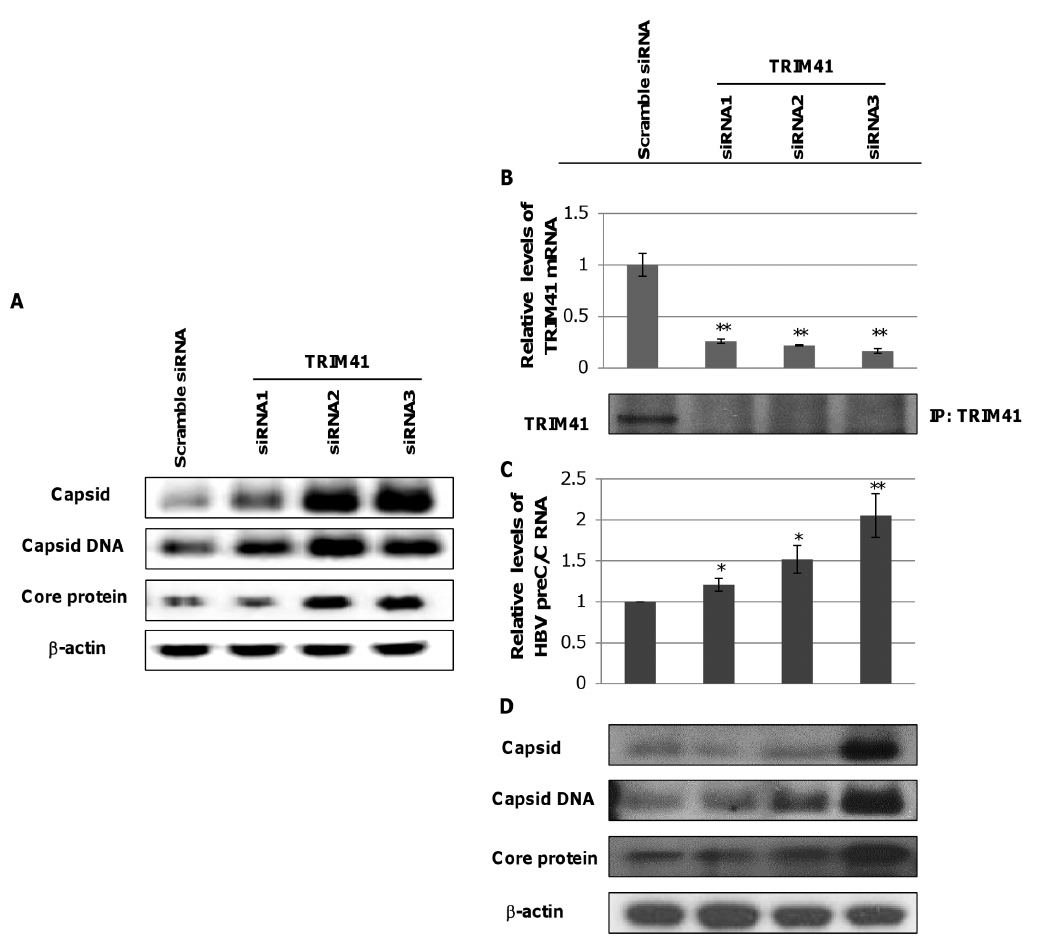
Figure 7. Endogenous TRIM41 inhibits HBV transcription in HepG2 cells. (A) HepG2 cells in 12 well plates were transfected with 20 nM of scramble siRNA or one of three siRNA specifically targeting TRIM41. Six hours later, the cells were co-transfected with 0.4 m g of pHBV1.3 and 0.4 m g of a plasmid expressing TRIM41. The cells were re-transfected with 20 nM of siRNA 24 hours later and harvested at 48 hours post pHBV1.3 and TRIM41- expressing plasmid transfection. Core protein was tested by Western blot with b -actin as a loading control. Capsid and capsid DNA were analyzed by a particle gel assay. (B) 15 nM of TRIM41 siRNAs or scramble siRNA were transfected into HepG2.2.15. Two days post transfection, cells were harvested. The total cellular RNAs were extracted and reverse transcribed. TRIM41 siRNA knockdown efficiency was tested by quantification of TRIM41 mRNA level with a quantitative RT-PCR assay (upper panel). The level of TRIM41 protein in the transfected cultures were determined by immunoprecipitation and Western blot assays with a polyclonal antibody against human TRIM41 (lower panel). (C) HBV preC/C RNA and total viral mRNA were quantified by a quantitative RT-PCR assay and normalized with b -actin mRNA as an internal control. (D) Core protein, capsid and capsid DNA levels were tested by Western blot or Southern blot assays. The same amounts of cell lysates were loaded after BCA quantification. The level of b -actin was used as a loading control. The mean and standard deviations (n=4) were presented. * and ** indicate P , 0.05 and 0.01, respectively.